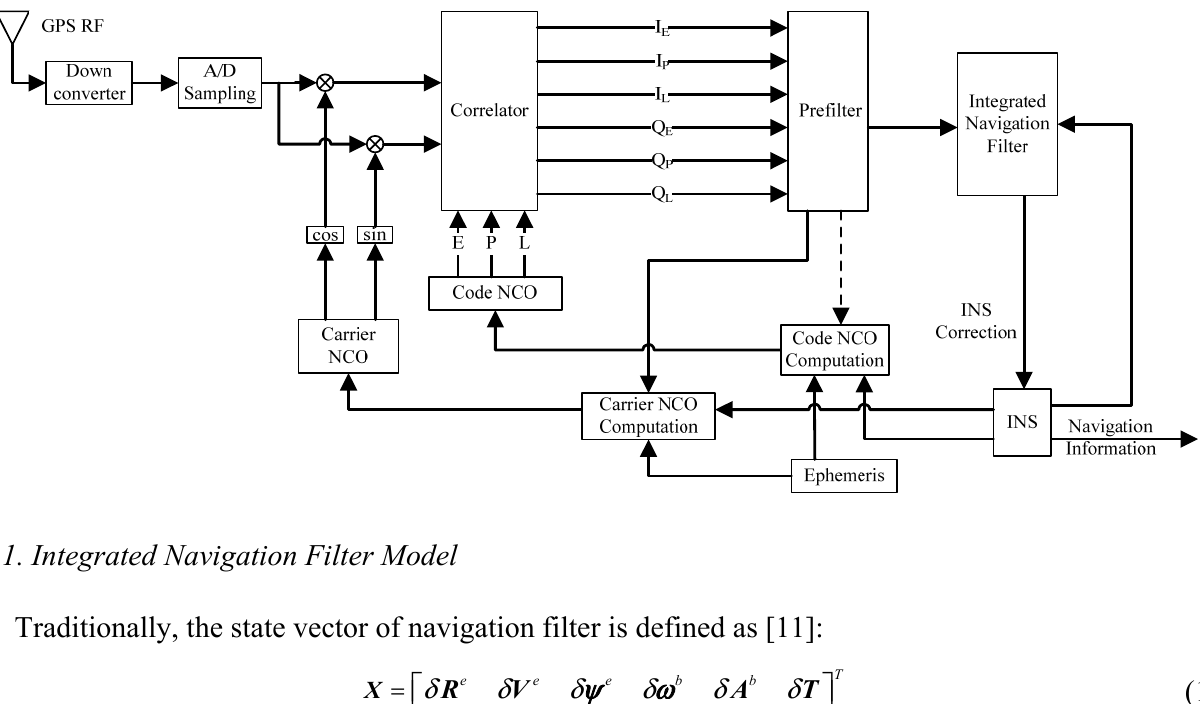
Figure 3. Federated ultra-tight GPS/INS integration with one channel in